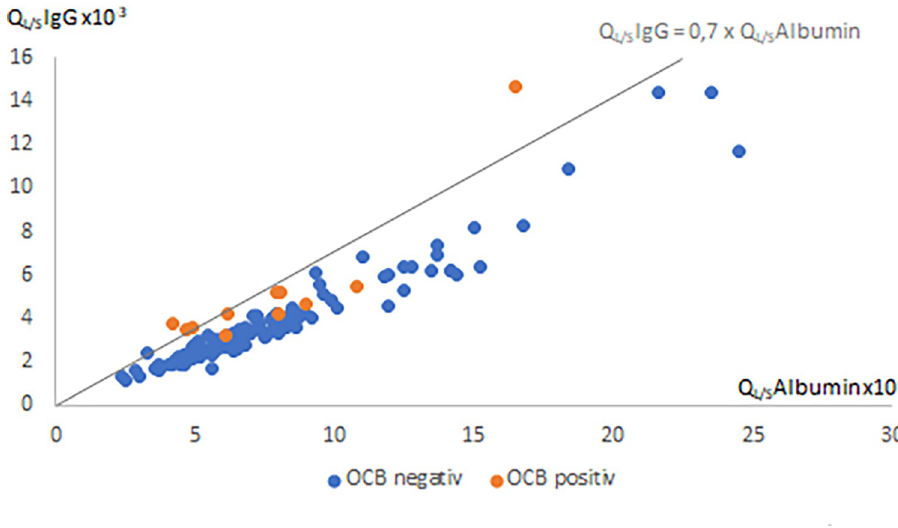
Fig 1. Quotient of CSF and serum IgG as well as quotient of CSF and serum albumin for all OCB positive (red spots) and OCB negative (blue spots) patients.